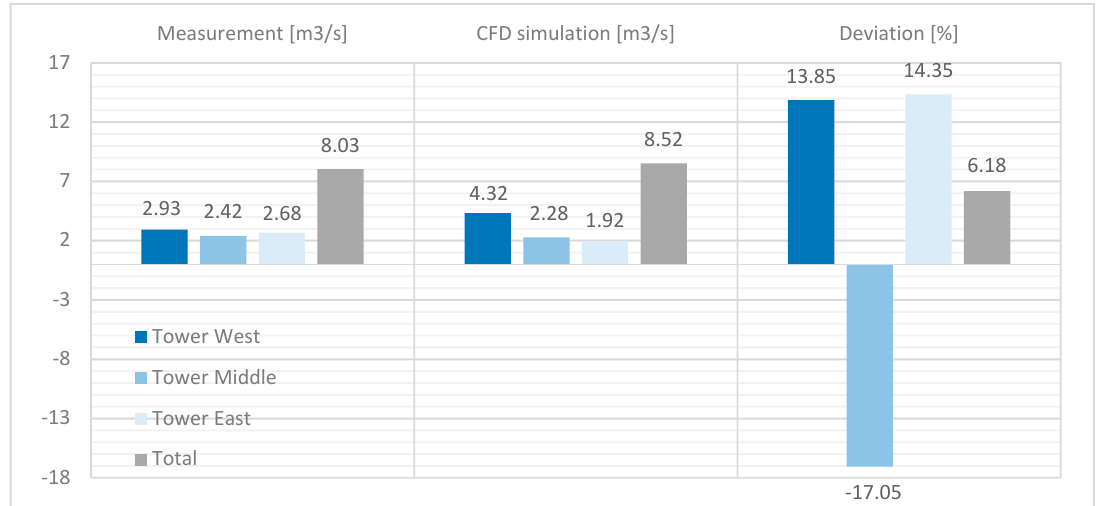
Figure 15. Measured and simulated air volume flow comparison in the three ventilation towers.